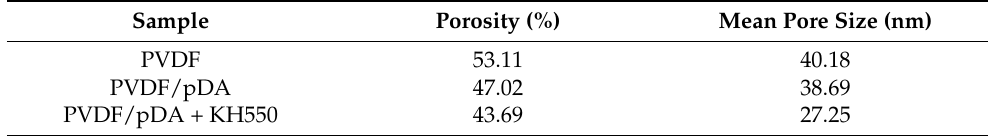
Table 3. Porosity and mean pore size of pristine and modified membranes.